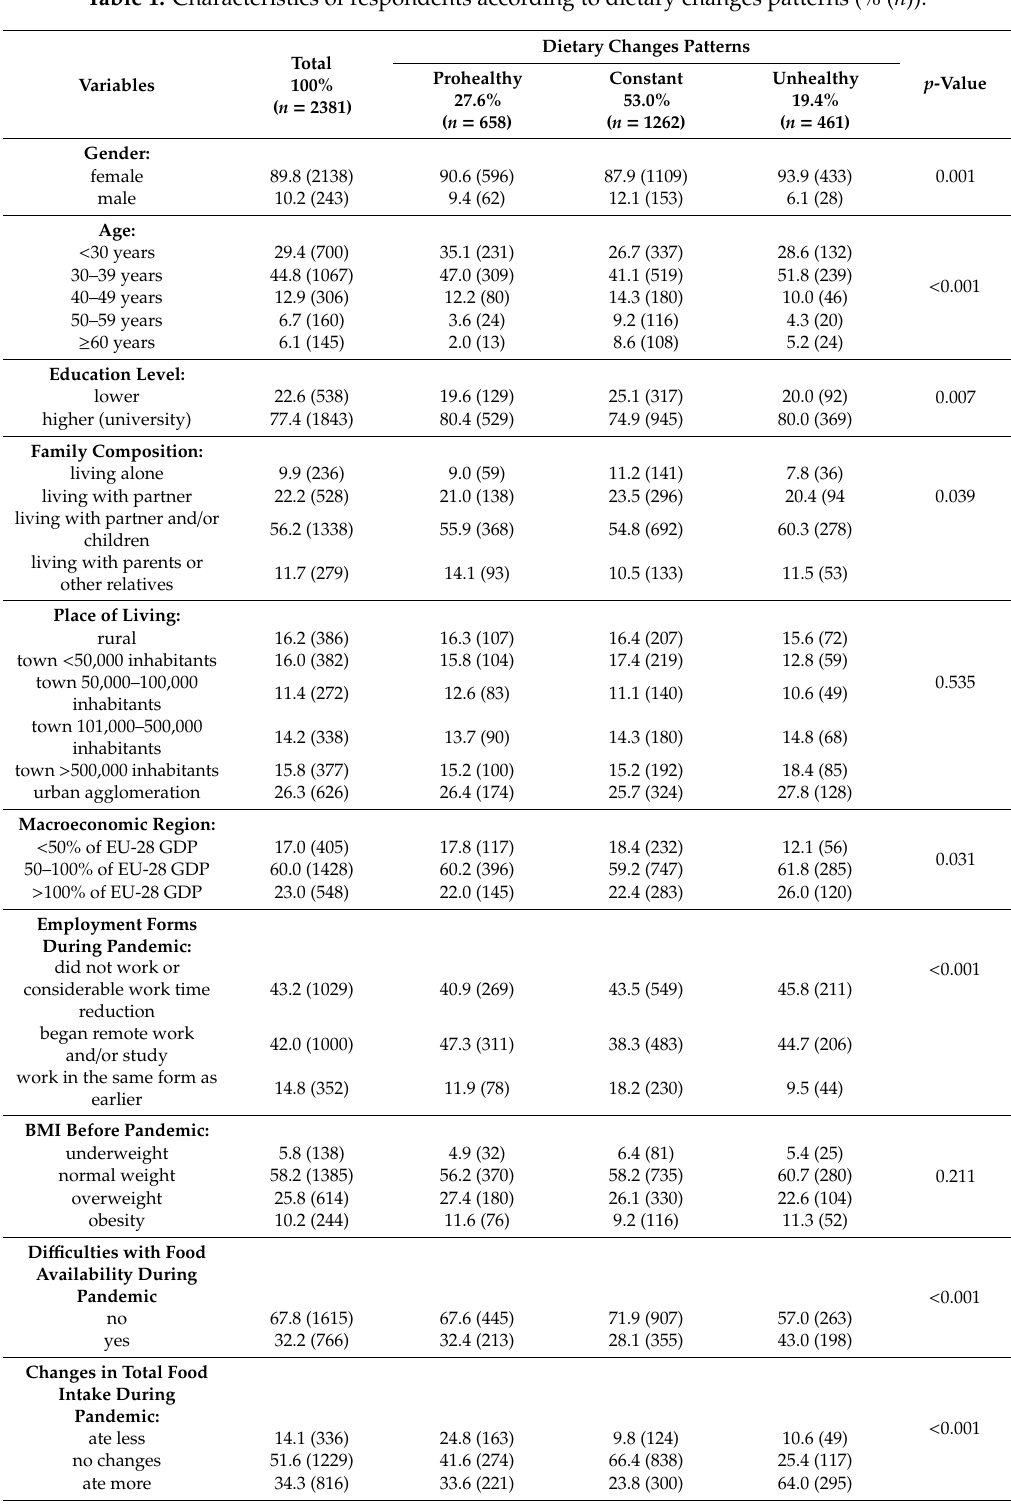
Table 1. Characteristics of respondents according to dietary changes patterns (% ( n